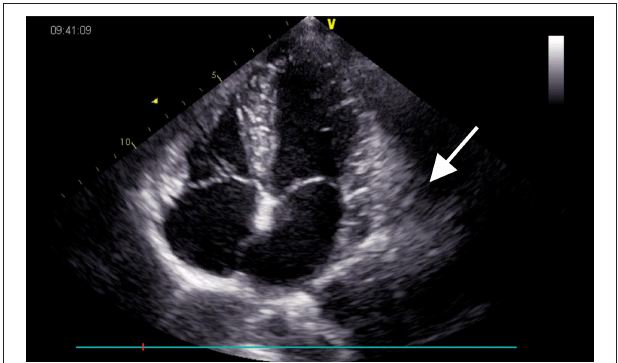
FIGURE 1 | Echocardiogram pre-operatively showing a 32 × 66mm heterogeneous mass (arrow) located in the left atrioventricular groove.